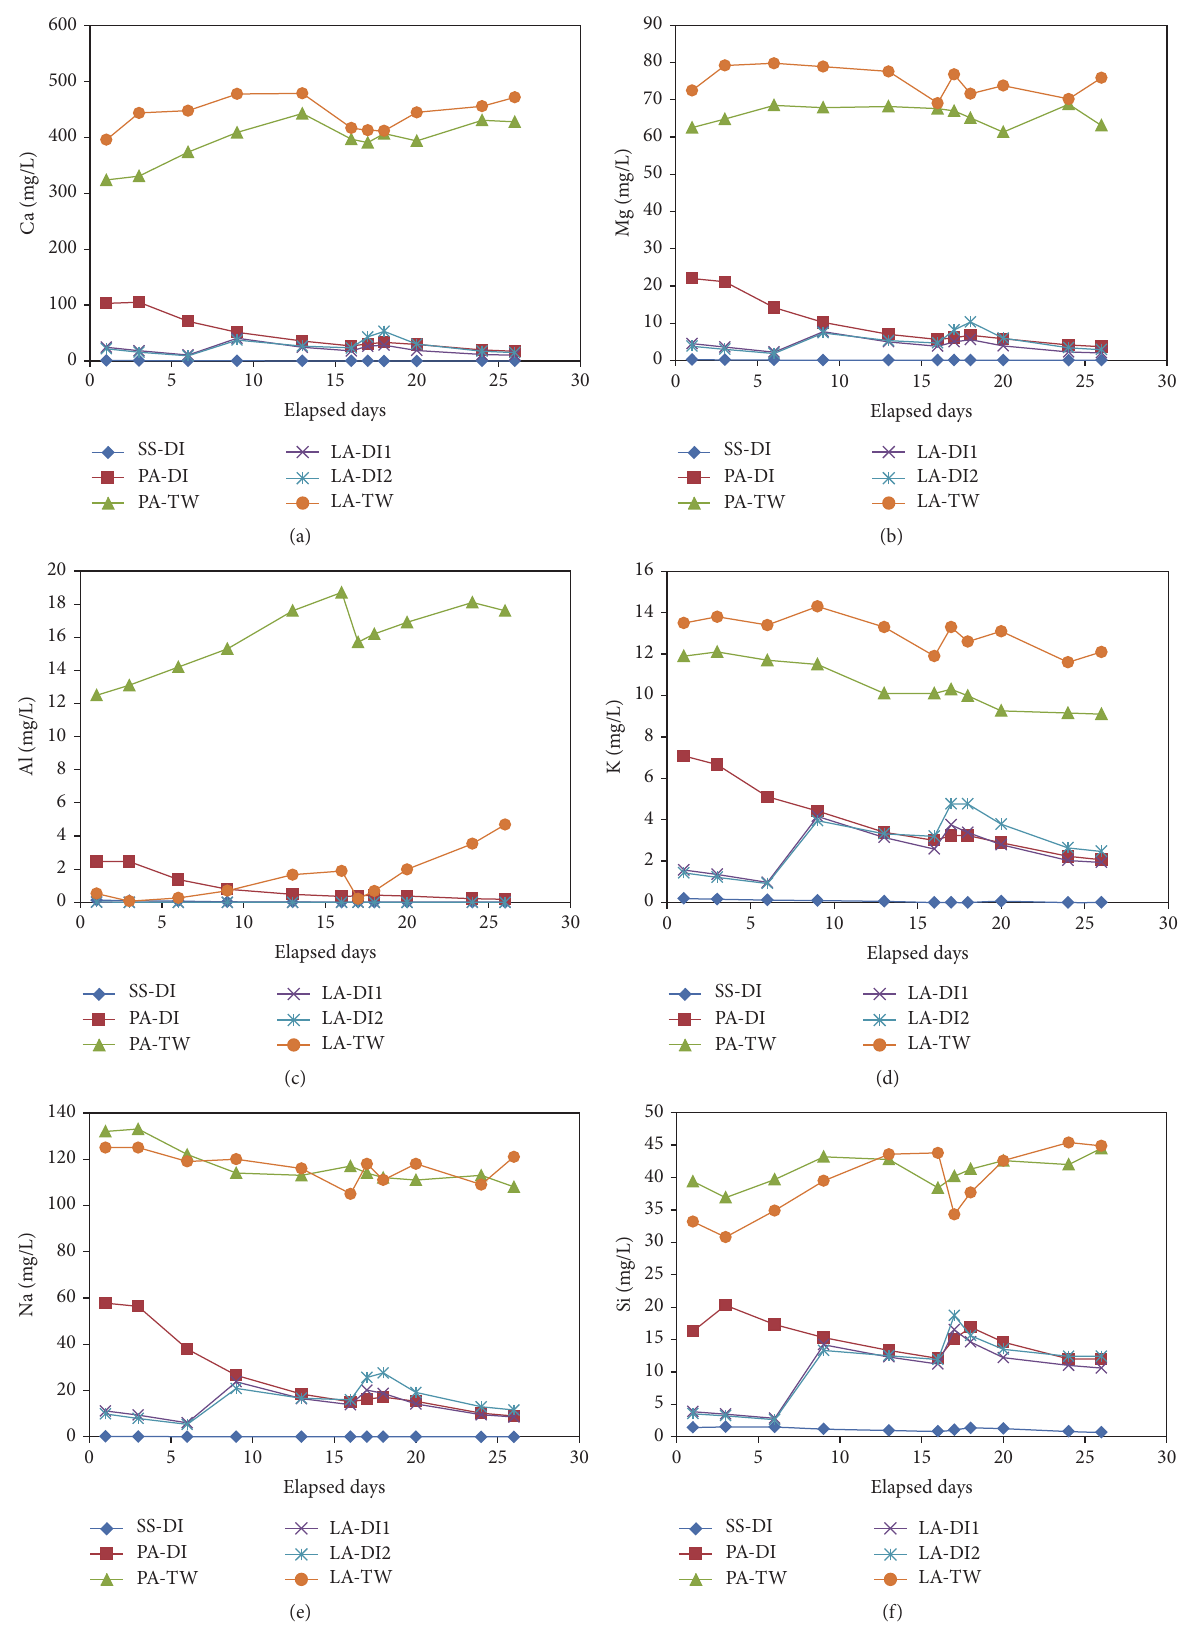
Figure 7: (a) Ca, (b) Mg, (c) Al, (d) K, (e) Na, and (f) Si concentrations measured over time for each